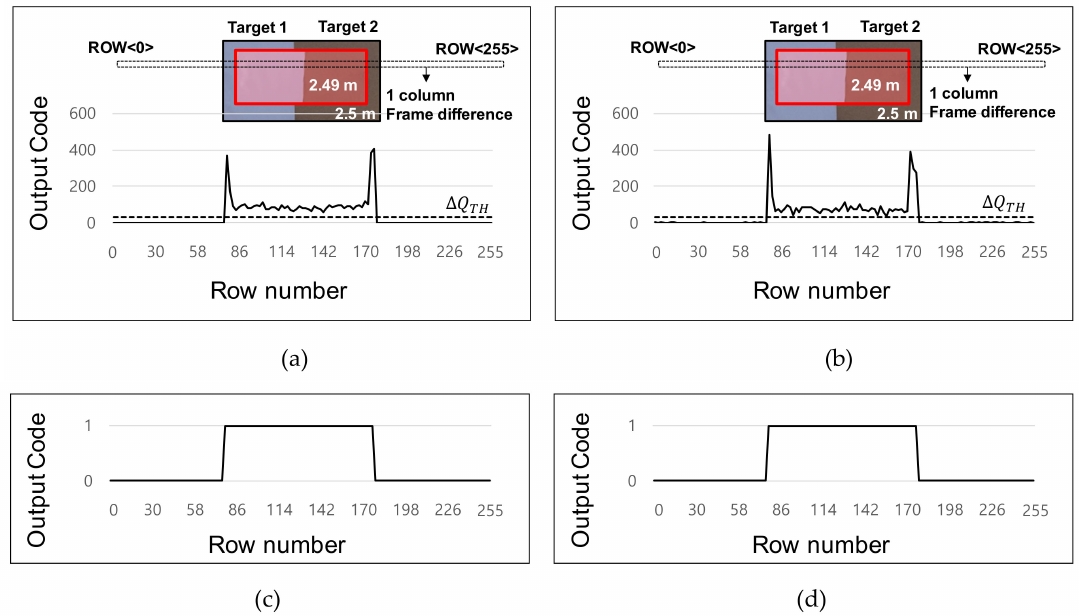
Figure 12. Captured line images of the depth frame di ff erence from the test column: ( a ) line image with application of a four-phase modulation scheme; ( b ) line image with application of a two-step comparison scheme; ( c ) binary detection result with application of a four-phase modulation scheme; ( d ) binary detection result with application of a two-step comparison